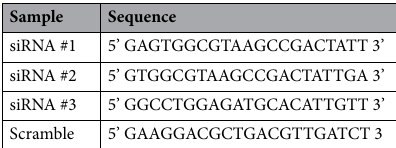
Table 1. The siRNAs sequences.